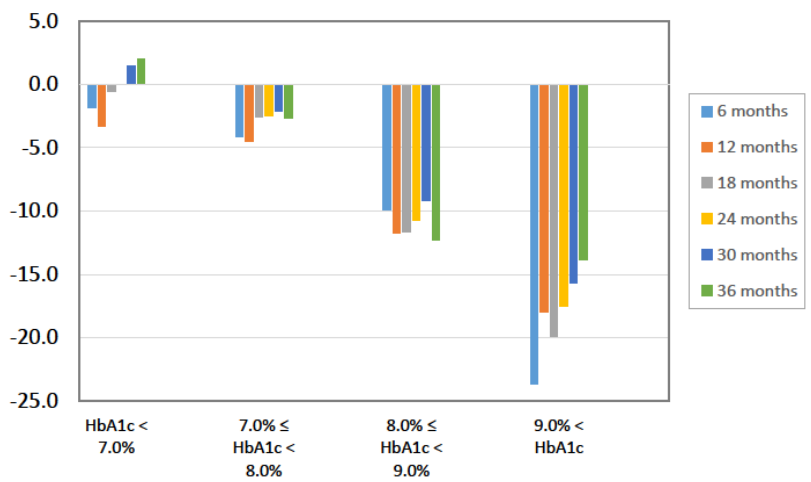
Figure 3. Percent changes in HbA1c stratified by baseline HbA1c (%).